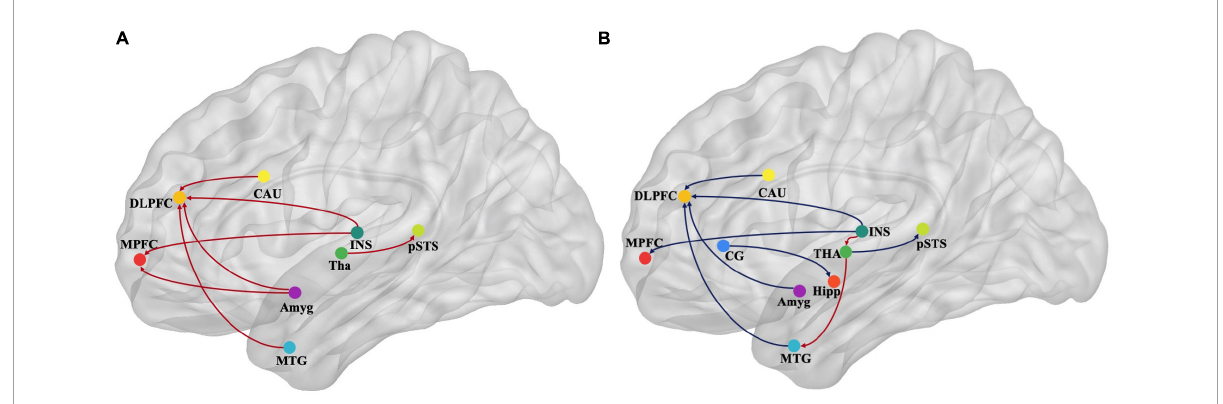
FIGURE4 Map illustrating brain of multivariate GCA signed-path coefficients alteration after treatment in the immersive-VR group (A) and the control group (B) . Some brain regions only showed projection position. Blue/red arrows designate significantly weaken/strengthen of causal connectivity after treatment as compared to baseline levels. MPFC, medial prefrontal cortex; DLPFC, dorsolateral prefrontal cortex; MTG, middle temporal gyrus; pSTS, posterior superior temporal sulcus; INS, insular gyrus; CG, cingulate gyrus; Amyg, amygdala; Hipp, hippocampus; CAU, caudate, Tha, Thalamus. GCA, granger causality analysis.